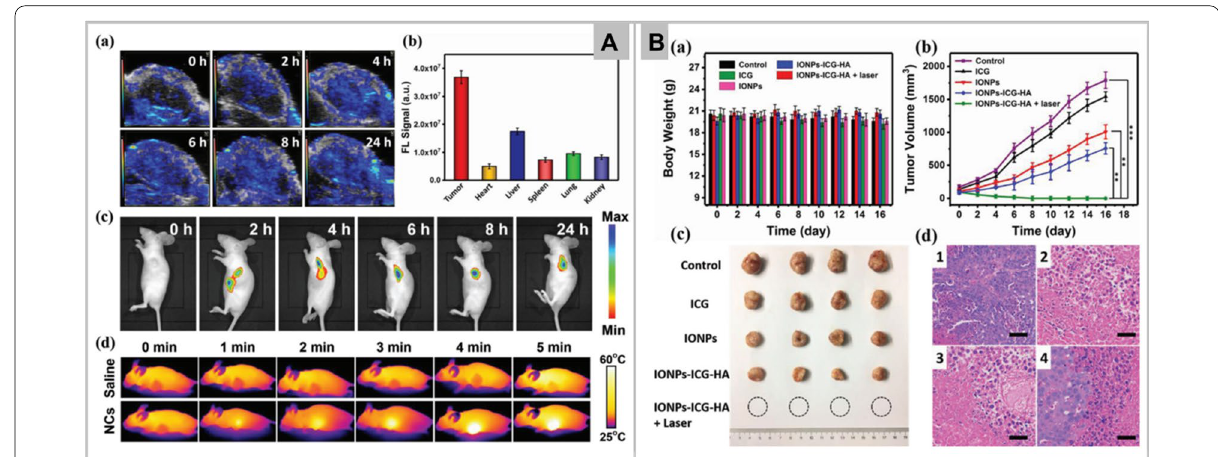
Fig. 4 a PA images of the mouse tumor at different times after injection of IONPs-ICG-HA. b Fluorescence signals of IONPs-ICG-HA in tumor and major tissues ( n 3, mean – SD). c Ex vivo fluorescence images of IONPs-ICG-HA injected mice. d Infrared thermal images of mice 6 h post = injection of saline or IONPs-ICG-HA under different irradiation time (Panel A ). a Body weight changes of nude mice during treatment ( n SD). b Tumor growth curves during treatment ( n 5, mean ** P < 0.01, *** P < 0.001. c Digital photos of tumors after PDT/PTT synergistic therapy. d = Histological microscopy images of tumors after treatments: 1 ) control, 2 ) ICG, 3 ) IONPs, and 4 ) IONPs-ICG-HA. (Scale bar: 50 μm) (Panel B ). Reprinted with permission from Small, Copyright 2019, John Wiley and Sons